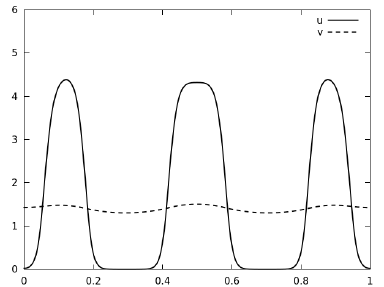
Fig. 1. A pattern with spikes. Parameter values are (cid:15) = 0 . 01 , d = 0 . 1 , µ u = 1 , µ v = 1 . 2